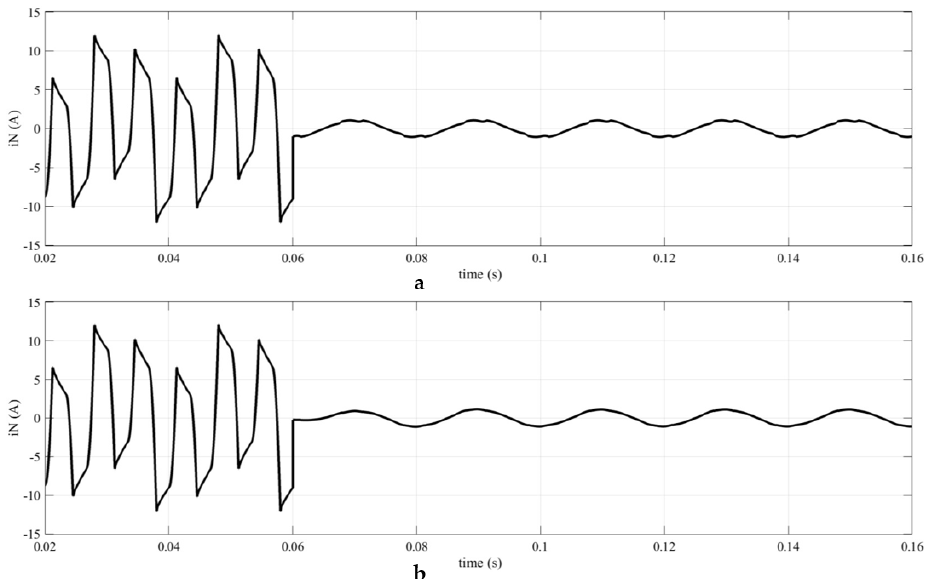
Figure 12 . ( a ) Neutral current for case 2 before/after TIC. ( b ) Neutral current for case 2 before/after TAC. Compensation at t = 0.06 s.